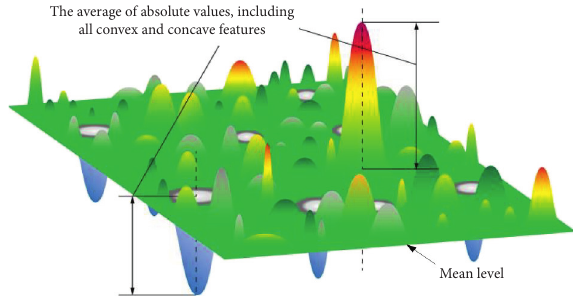
Figure 1: Schematic diagram of the surface arithmetic mean de- viation S a